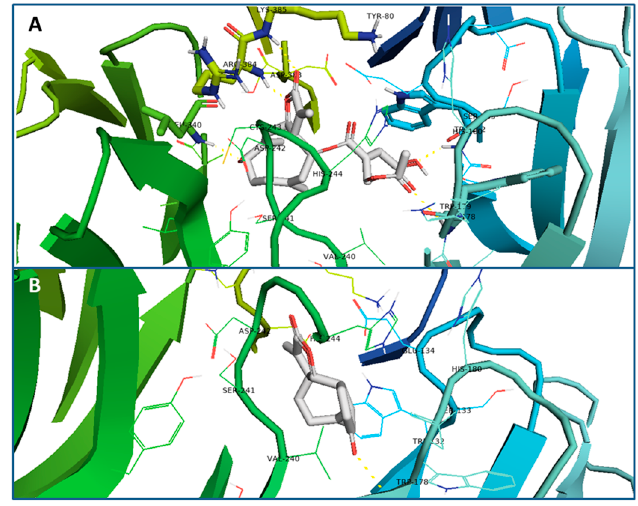
Figure 7. ( A ) Best interaction pose for santhemoidin C (in gray) with target Tc80. Five hydrogen bonds can be observed (yellow lines) with residues Trp 178, Trp 132, Lys 385, Leu 340 and Arg 384. ( B ) Best interaction pose for 2-oxo-8-deoxyligustrin (in grey) with target Tc80. One hydrogen bond formed can be observed with residue Trp178 (yellow lines).